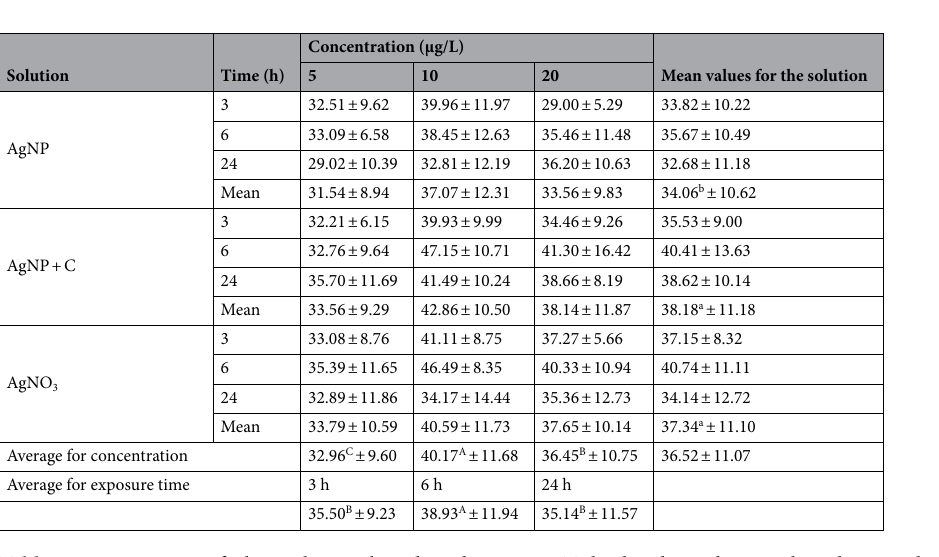
Table 1. Genotoxicity of silver solutions based on the % DNA Tail value depending on the solutions, their concentrations and exposure time. a, b, c—values for solutions marked with different letters vary significantly ( p ≤ 0.05). A, B, C—Mean values for concentration and time marked with different letters differ significantly ( p ≤